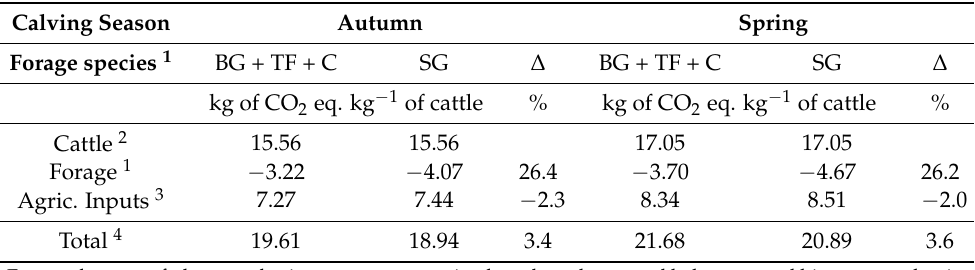
Table 5. Changes in net GHG emissions in kg of CO2 eq. per kg of live weight of cattle sold. Calving Season